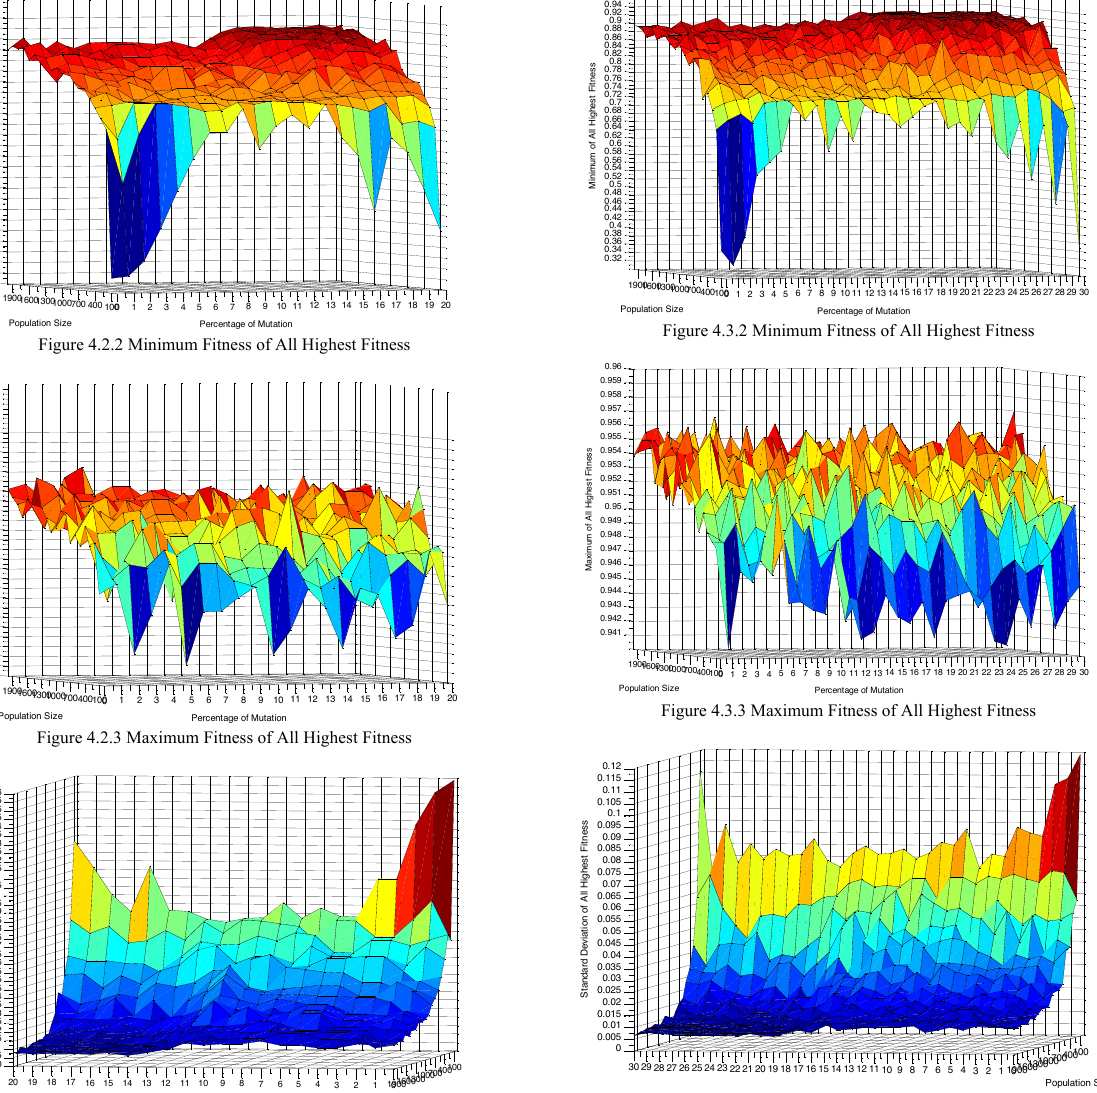
Figure 4.3.4 Standard Deviation of All Highest Fitness Figure 4.3 Total Percentage of Mutation and Crossover is 30% (Mutation over